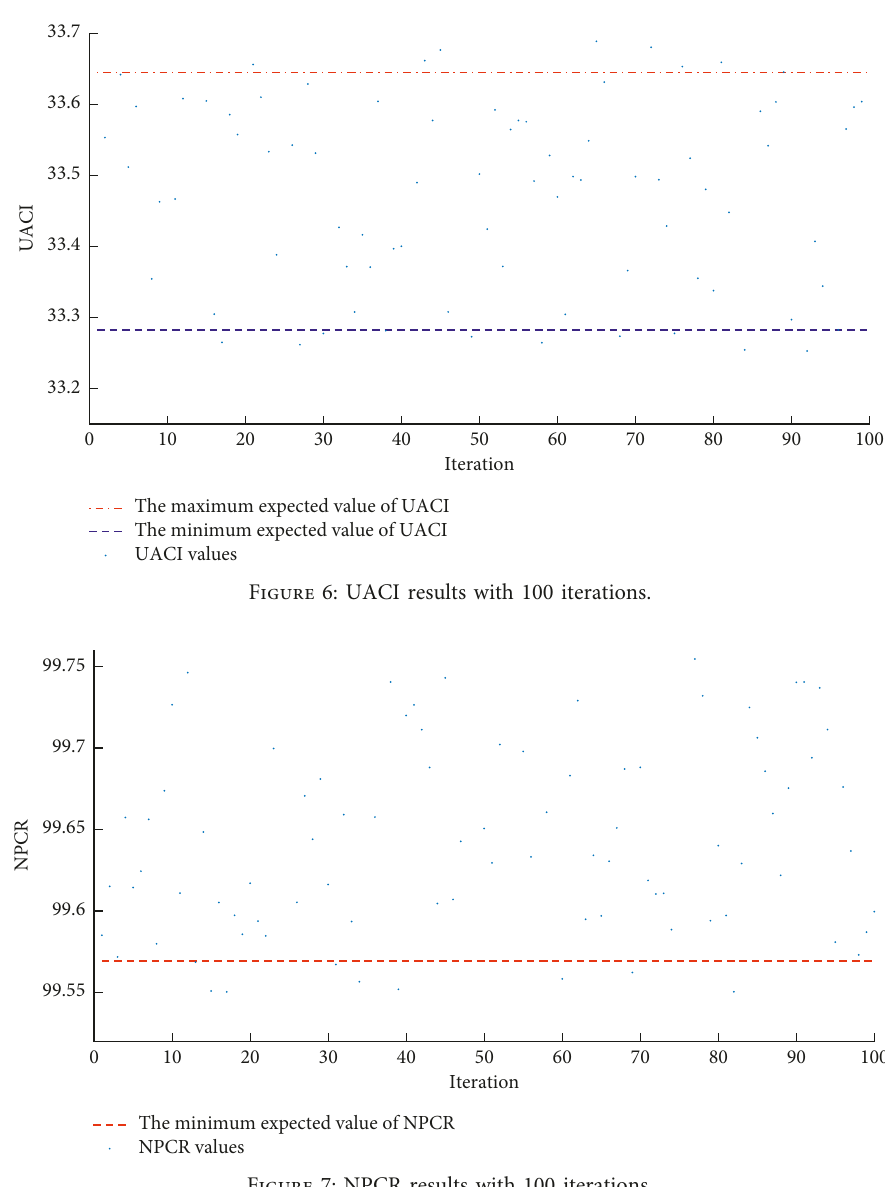
Figure 7: NPCR results with 100